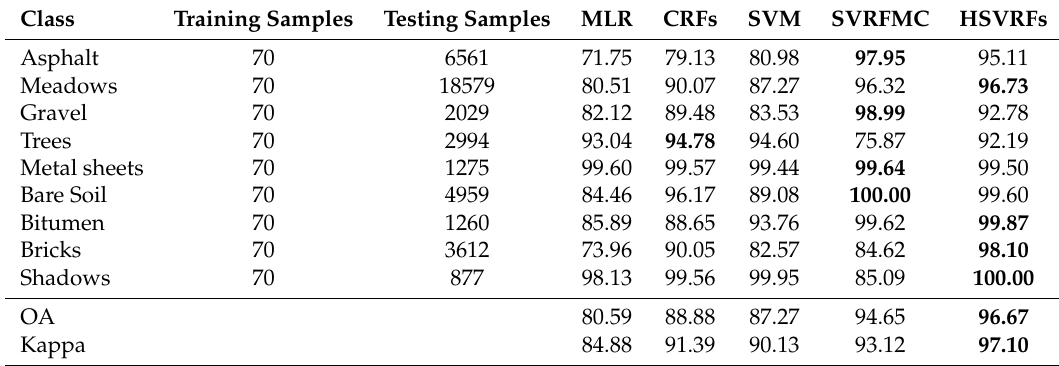
Table 3. Classification accuracies of the different algorithms for the Pavia University dataset